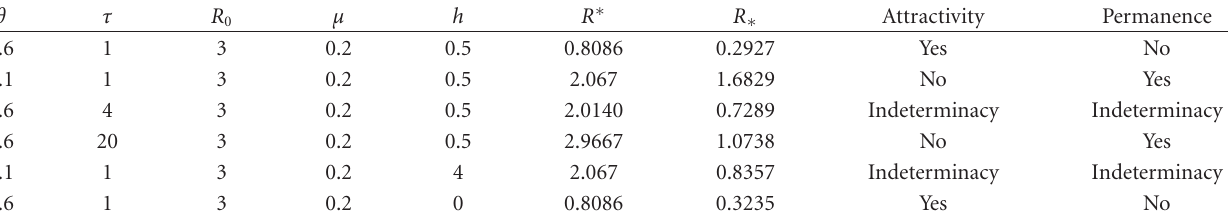
Table 1: The e ff ect of parameters θ , τ , R 0 , μ and h on the global attractivity of the infection-free periodic solution and the permanence of epidemic